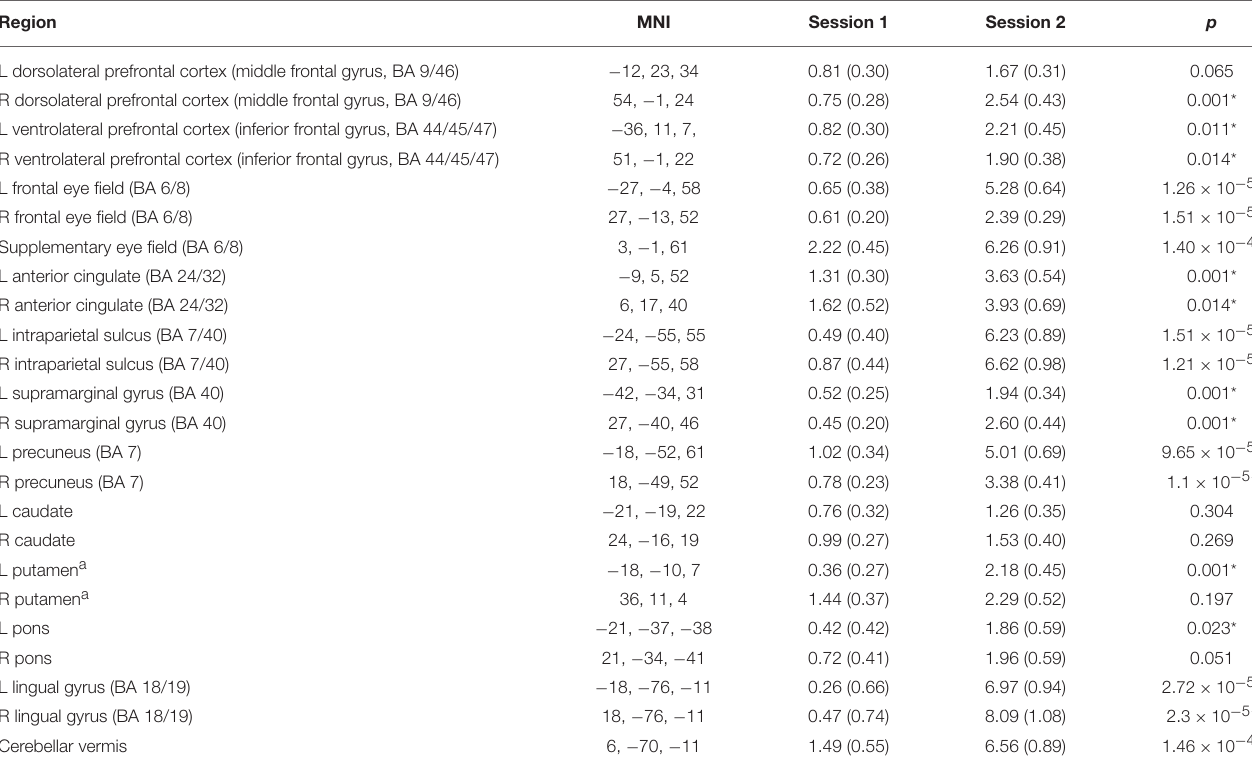
TABLE 3 | MNI coordinates and mean (standard error) contrast values for each region of interest for antisaccade trials session 1 and 2. Region